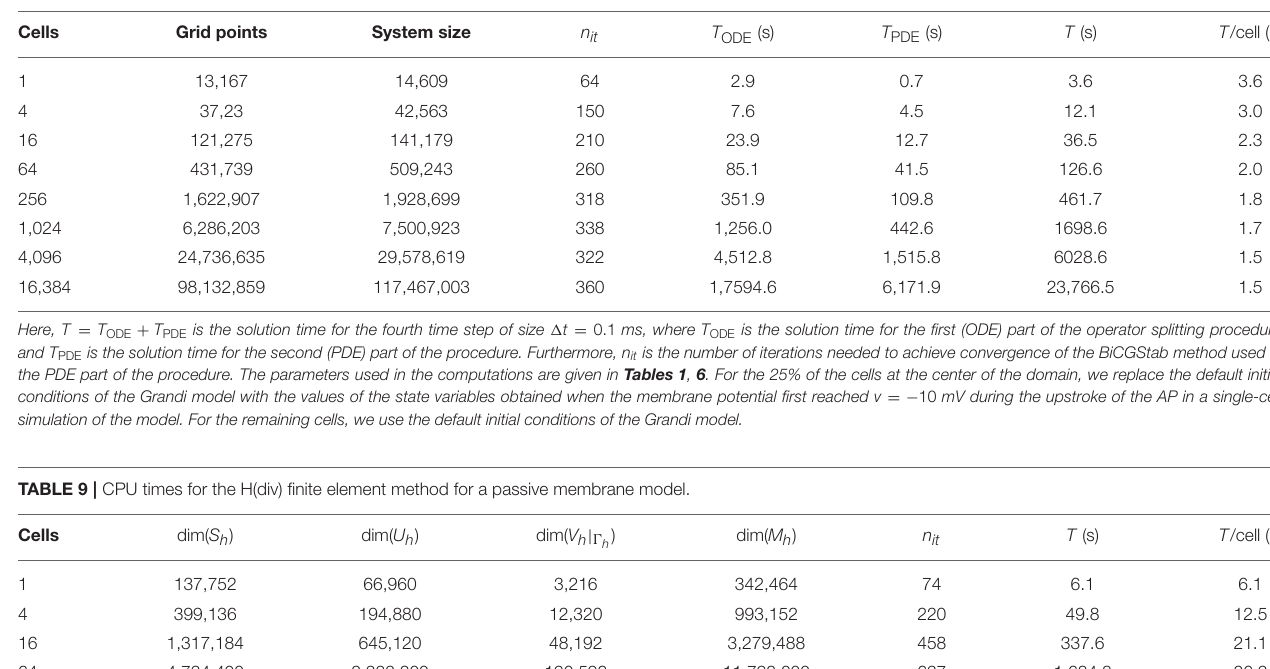
Figure 7 shows the solutions of two simulations of a collection of 30 × 5 cells with different distributions of the sodium channel conductance, g Na . In the left panel the value of g Na is constant on the entire membrane, while, in the right panel, g Na is zero over a large part of the membrane and only non- zero on (cid:127) and (cid:127) , that is, near the ends of the cell in the W E